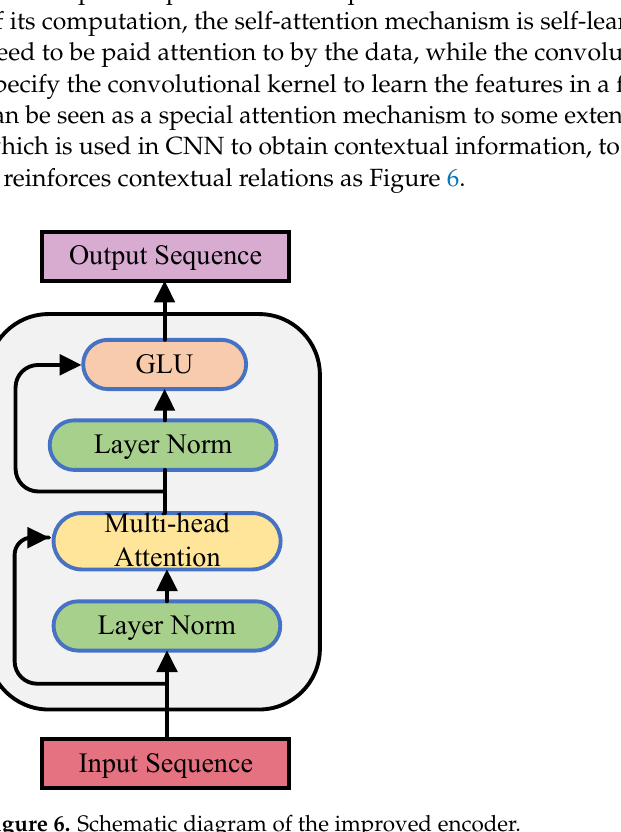
Figure 6. Schematic diagram of the improved